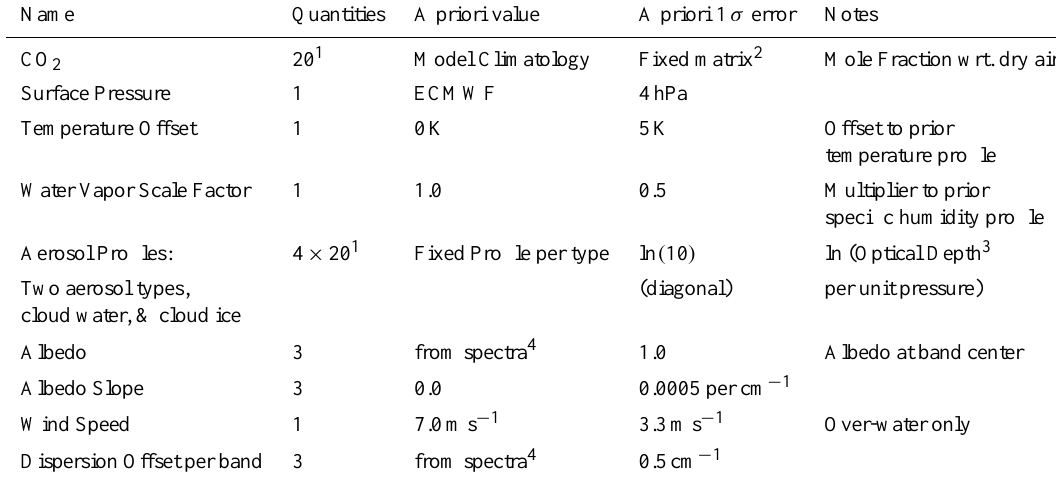
Table 2. State Vector Composition.